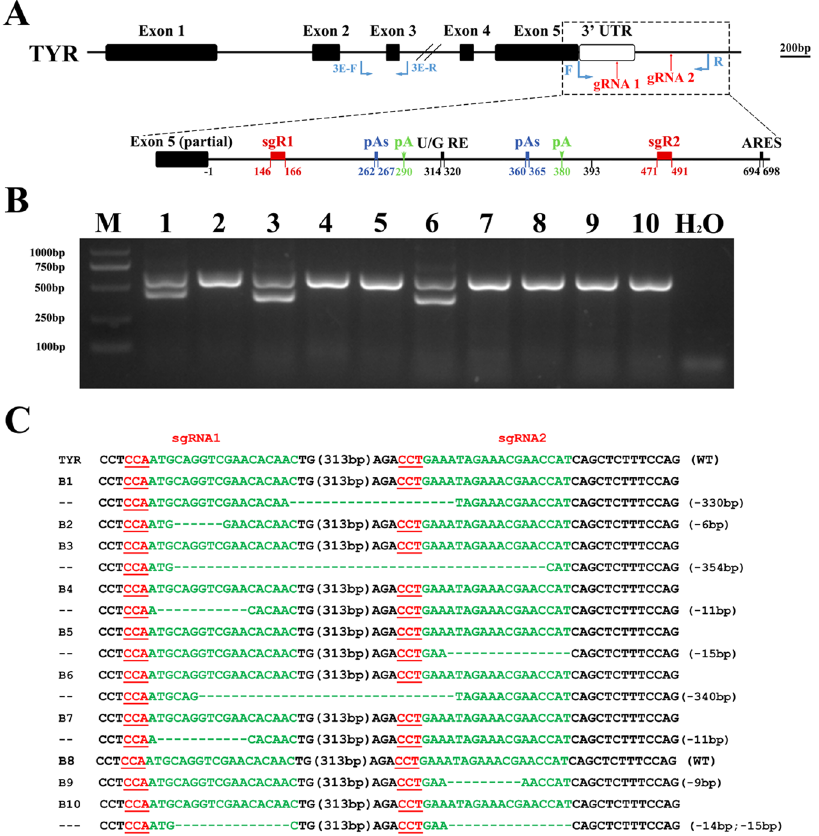
Figure 1. Dual sgRNA-directed deletion of the Tyr 3 ′ UTR in zygotes. ( A ) Schematic diagram of 3 ′ polyA tail, sgRNAs and primers targeting the rabbit TYR 3 ′ UTR loci. Two sgRNAs are marked in red and the primers are presented in blue. pAs: poly ( A ) addition signal; pA: poly ( A ) site; U/G RE: U/G rich area. AREs: AU-rich elements. ( B ) Mutation detection in blastocyst by PCR. M, marker; 1–10 represent different blastocysts used in this study. Original images are included “Authors’ original file for Fig. 1B”. ( C ) Mutation detection in blastocyst by T-cloning and Sanger sequencing. The WT sequence is shown at the top of the targeting sequence. sgRNA sequences are marked in green and the protospacer adjacent moti (PAM) sequences are in red with underline. WT: wild type; deletions “ − ”; insertion “ +